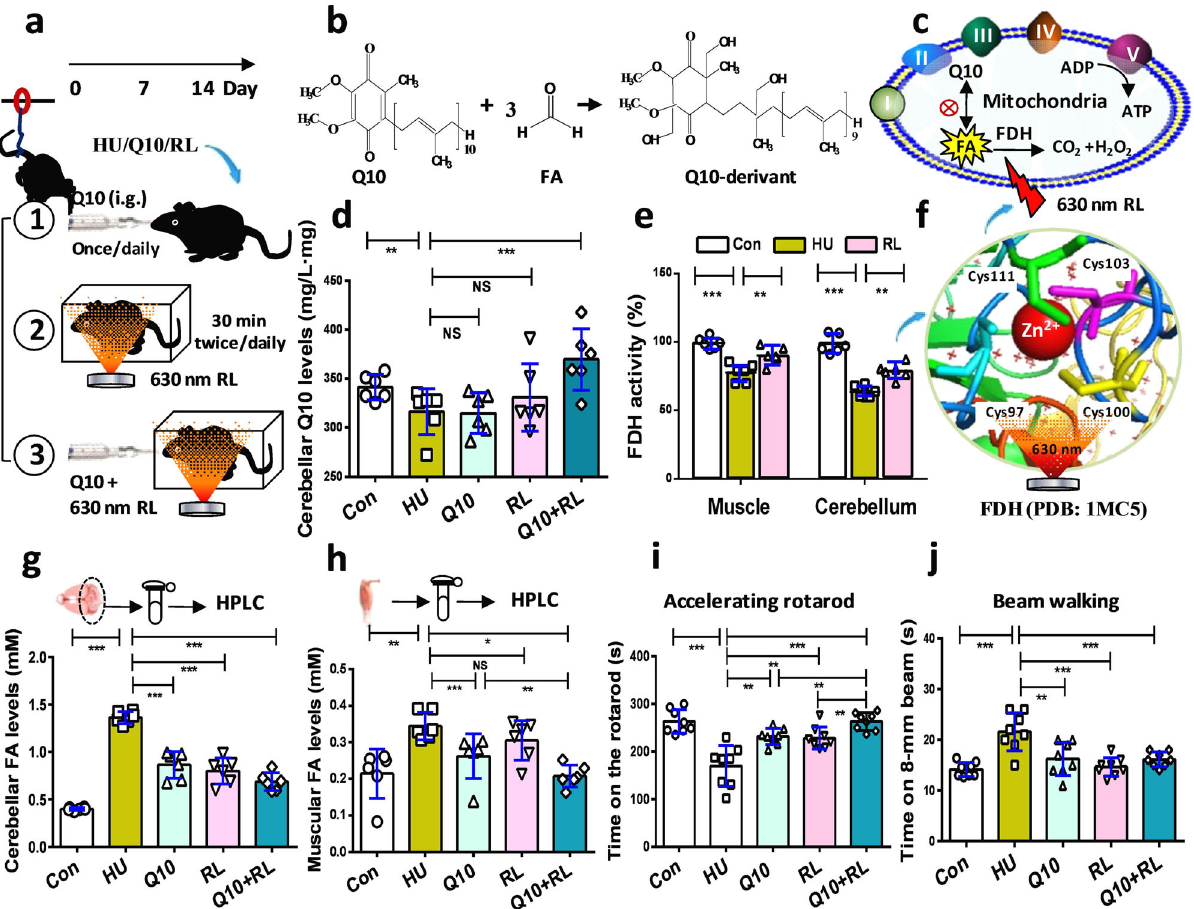
Fig. 7 Reduction of systemic formaldehyde rescued motor functions in the mice of hindlimb unloading. a The experimental fl ow. HU: mice of hindlimb unloading; Q10: HU mice intragastrically administered (i.g.) 30-nm coenzyme Q10; RL: HU mice illuminated with 630-nm red light. b The spontaneous chemical reaction between Q10 and formaldehyde. FA formaldehyde. c Metabolism of formaldehyde and coenzyme Q10 in the mitochondria. d Coenzyme Q10 levels quanti fi ed by the ECA- fl uorescence method ( n = 6). e FDH activity detected using an FDH kit ( n = 6). FDH formaldehyde dehydrogenase. f Schematic diagram of the effects of and the activation of the Cys97 and Cys100 residues in FDH by 630-nm red light (PDB: 1MC5). Cys: cysteine; Cys111 (green); Cys103 (purple); Cys97 (dusty blue); Cys100 (yellow). g , h Formaldehyde levels quanti fi ed by HPLC ( n = 6). HPLC high-performance liquid chromatography. i , j Motor functions assessed by accelerating rotarod and beam walking tests, respectively ( n = 8). Error bars show the mean ± S.E.M; ** p < 0.01; *** p <